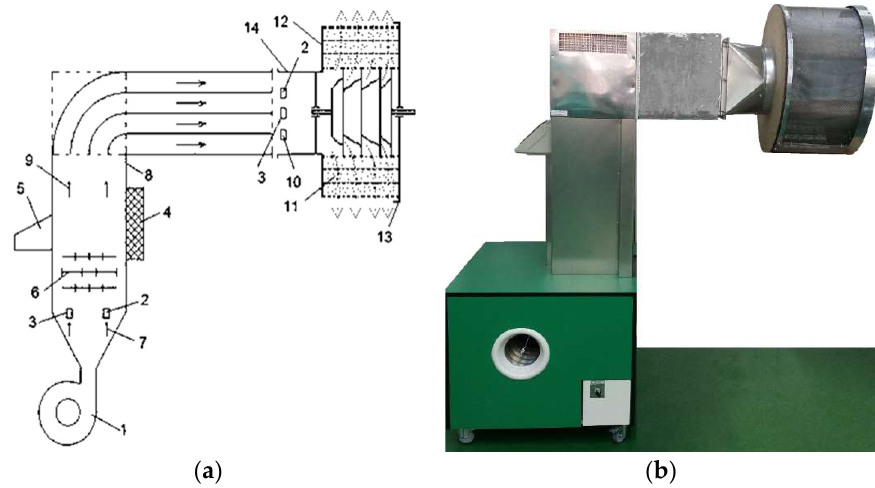
Figure 1. Laboratory dryer scheme with the cylindrical baffled drying unit. ( a )—functional scheme,